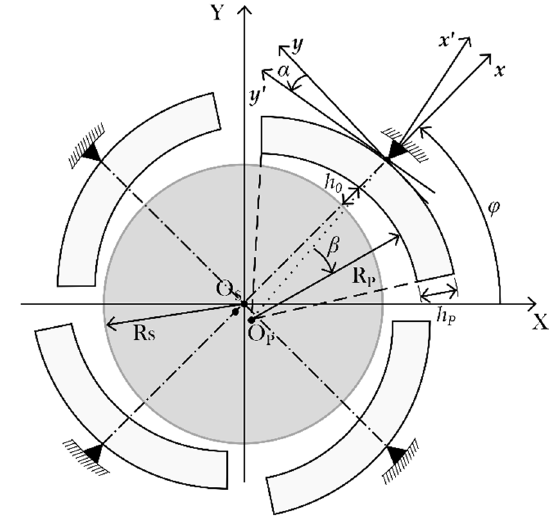
Figure 1. Front view schematic of the tilting pad journal bearing. After the sequences of steps cited above, the equivalent coefficients are finally obtained using the perturbation method [1,2,16], which consists of applying small perturbations to the shaft displacements and velocities around its equilibrium position, including the angular displacements and angular velocities of the bearing pads as well. Considering laminar flow bearings with small clearance ratios and reduced Reynolds number, the mass terms due to the fluid are neglected. Therefore, it yields nine stiffness and nine damping coefficients for each pad of the bearing concerning the local referential system (x’,y’). Once the equation of motion of the j-th pad is transformed to the global coordinates (X,Y), the fundamental equation of motion for a tilting pad bearing rigid rotor system is given by Equation (1)